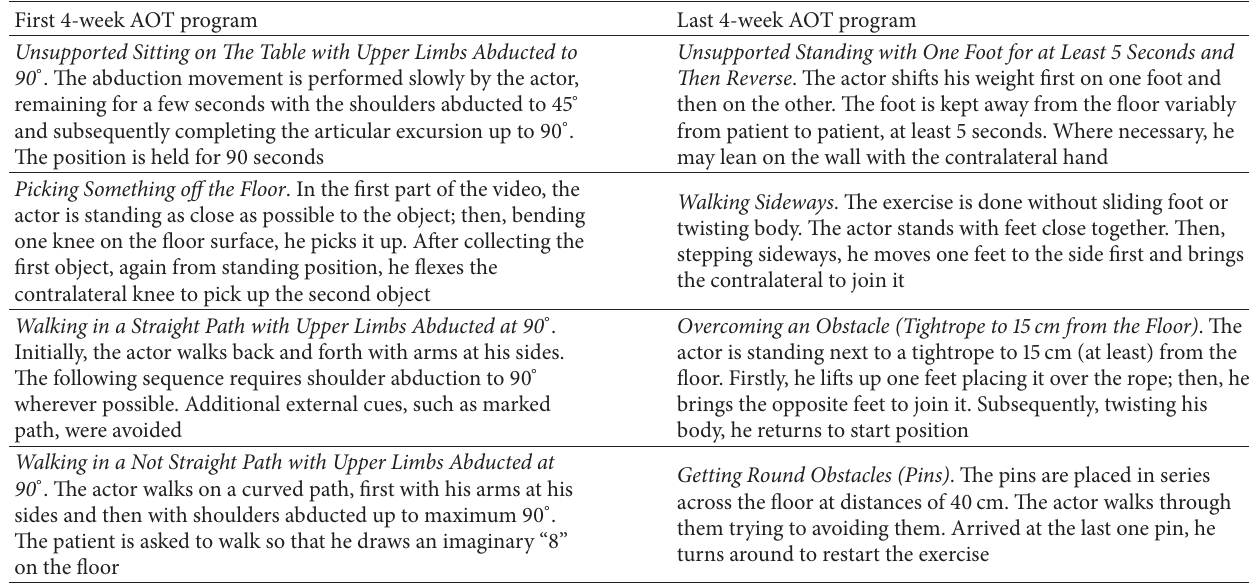
Table 1: Videos for Action observation treatment (AOT) shown to the Parkinson’s disease patients in the present open-label feasibility prospective study.